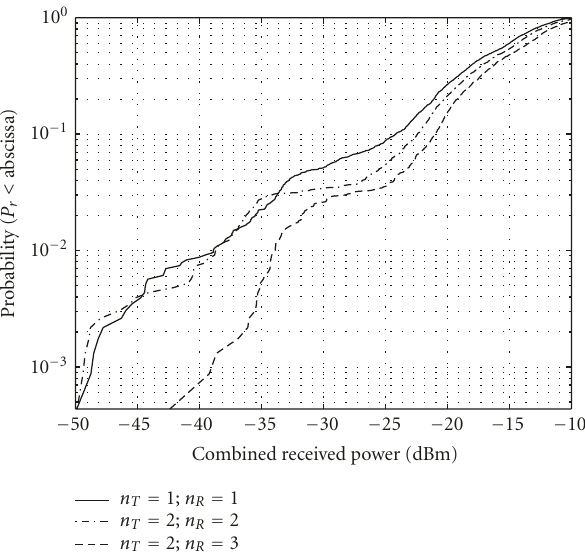
Figure 12: CDF of the envelope correlation (Scenario 2).